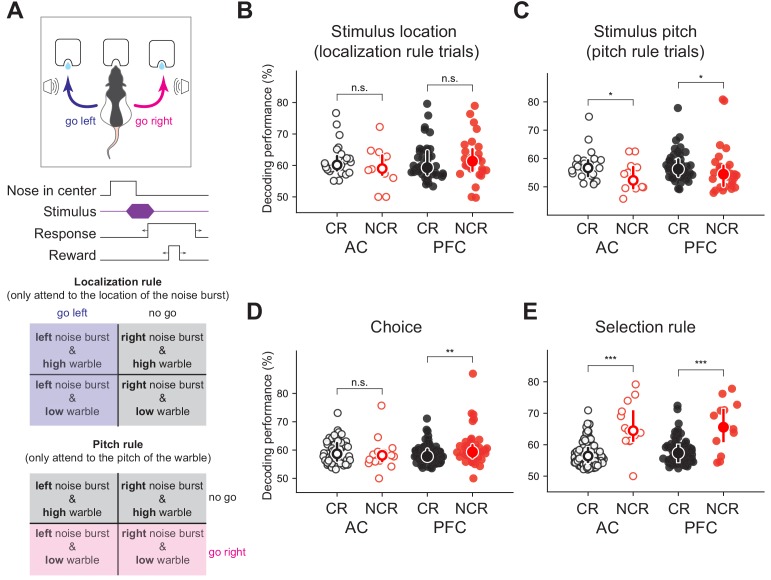
Non-classically responsive cells in both auditory cortex and prefrontal cortex (PFC) encode behavioral variables including the selection rule in a task switching paradigm.(A) Schematic of novel auditory stimulus selection task. Animals were presented with two simultaneous tones (a white noise burst and warble) and trained to respond to the location of the sound in the ‘localization’ context while ignoring pitch and respond to the pitch while ignoring the location in the ‘pitch’ context (figure adapted from Rodgers and DeWeese, 2014), Neuron). Decoding performance for (B) stimulus localization on localization trials (pAC = 0.24, pPFC = 0.21, Mann-Whitney U test, two-sided), (C) stimulus pitch on pitch trials (pAC = 0.48, pPFC = 0.47, Mann-Whitney U test, two-sided), and (D) choice (**pAC = 0.0064, pPFC = 0.22, Mann-Whitney U test, two-sided) for classically responsive cells (black) and non-classically responsive cells (red; no stimulus modulation or ramping activity) in auditory (open symbols) and prefrontal cortex (closed symbols) previously reported but not further analyzed in this study. (E) Decoding performance for the selection rule for classically responsive (black) and non-classically responsive cells (red; similar pre-stimulus firing rates for both pitch and localization blocks; ***pAC = 5 × 10−6, ***pPFC <0.0002, Mann-Whitney U test, two-sided).